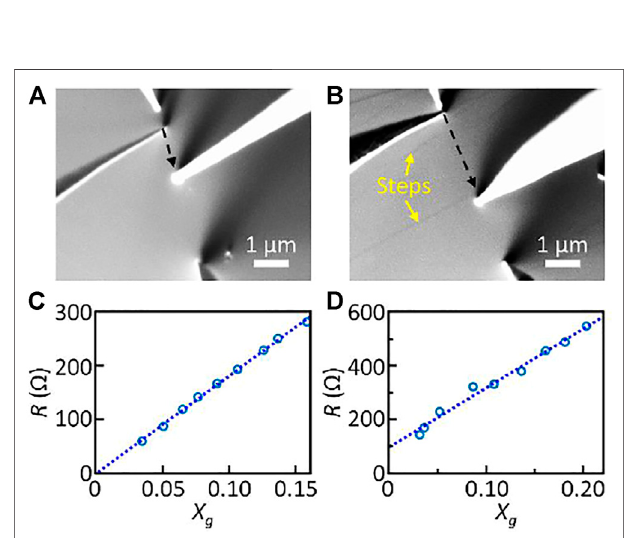
FIGURE 2 | (A,B) SEM images of Bi 2 Te 2 Se surface without and with atomic steps, respectively. Four tips are placed in collinear con fi guration for variable probe-spacing transport spectroscopy. (C,D) Four-probe resistance R versus X g of the surface without and with atomic steps,